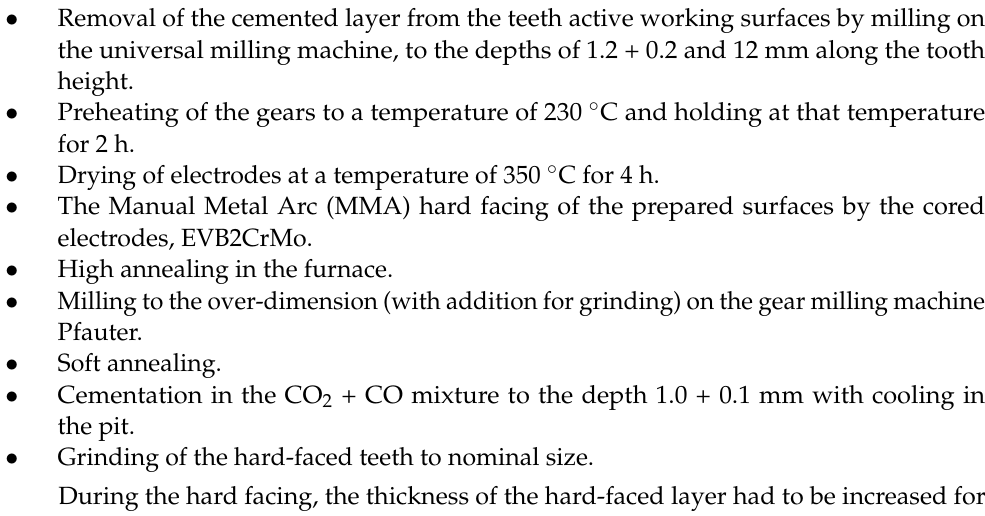
The metallographic investigations were conducted on the quantitative optical metallo- graphic microscope POLYVAR-MET (Leica Reichart-Jung, Wien, Austria) with magnifica- tions of 20 to 2000 times [26]. Figure 1 presents the microstructure of the cemented layer and of the transient zone of the hard-faced tooth.